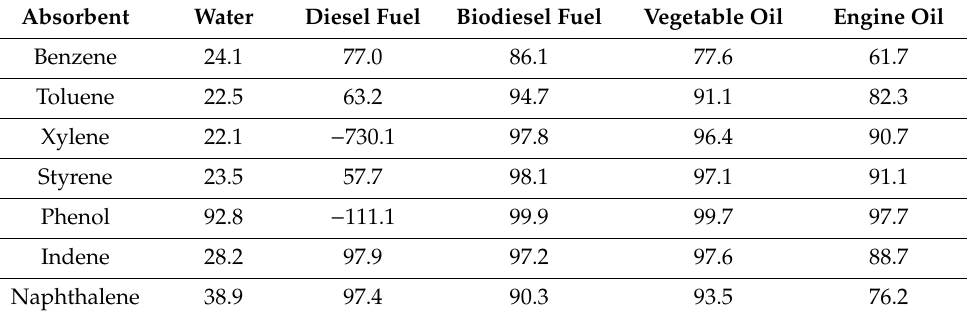
Table 1. Absorption e ffi ciencies of tar components by di ff erent solvents (%)